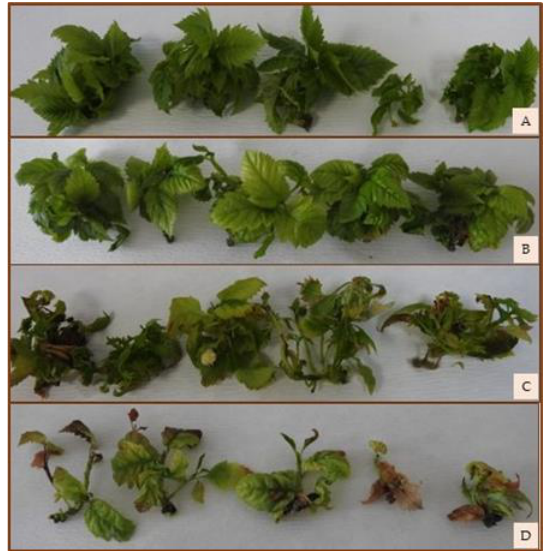
Figure 3. Shoot cultures of Sorbus redliana ‘Burokvölgy’ after storage at 4 °CD and darkness for four weeks ( A ), 16 weeks ( B ), 24 weeks ( C ), 36 weeks ( D ), 40 weeks ( E ), 44 weeks ( F ), 48 weeks ( G ), and 52 weeks ( H , I , J ).